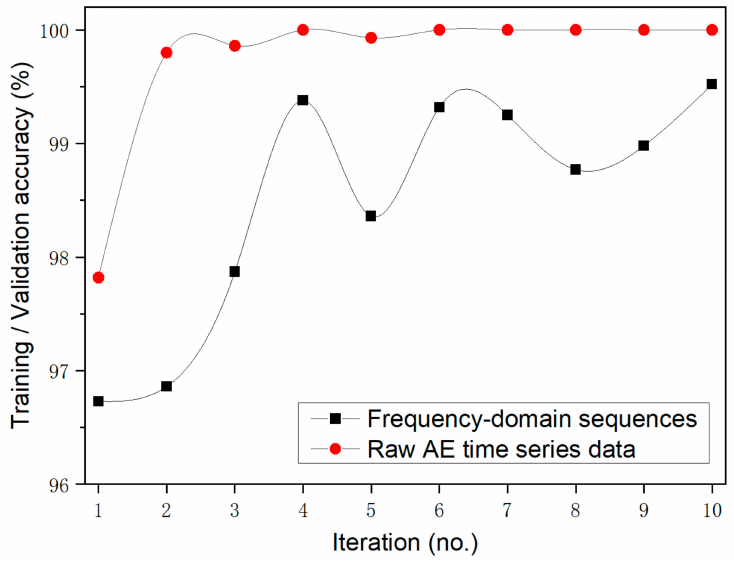
Figure 13. Comparing average test accuracy over 10 tests using the Inception network for raw AE time series data and frequency-domain sequences.